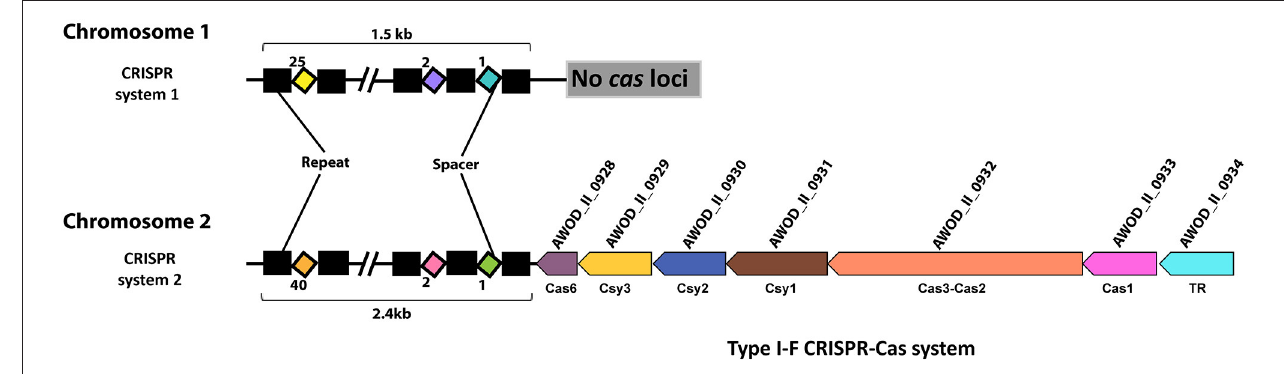
FIGURE 2 | CRISPR systems in A. wodanis 06/09/139. The figure shows the CRISPR arrays with repeats (black rectangle) and spacers (colored diamonds). In CRISPR system 2, the CRISPR array is located close to the cas operon (arrows) of the Type I-F CRISPR-Cas system. TR denotes transcriptional regulator.